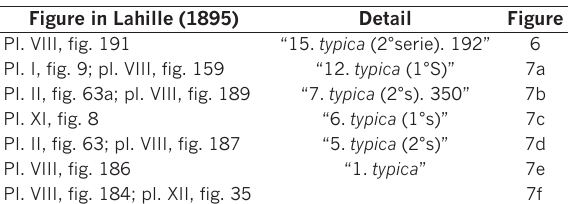
Table 2. Voluta ancilla typica , specimens figured by Lahille (1895) with the details of the inscriptions on their shells and figures